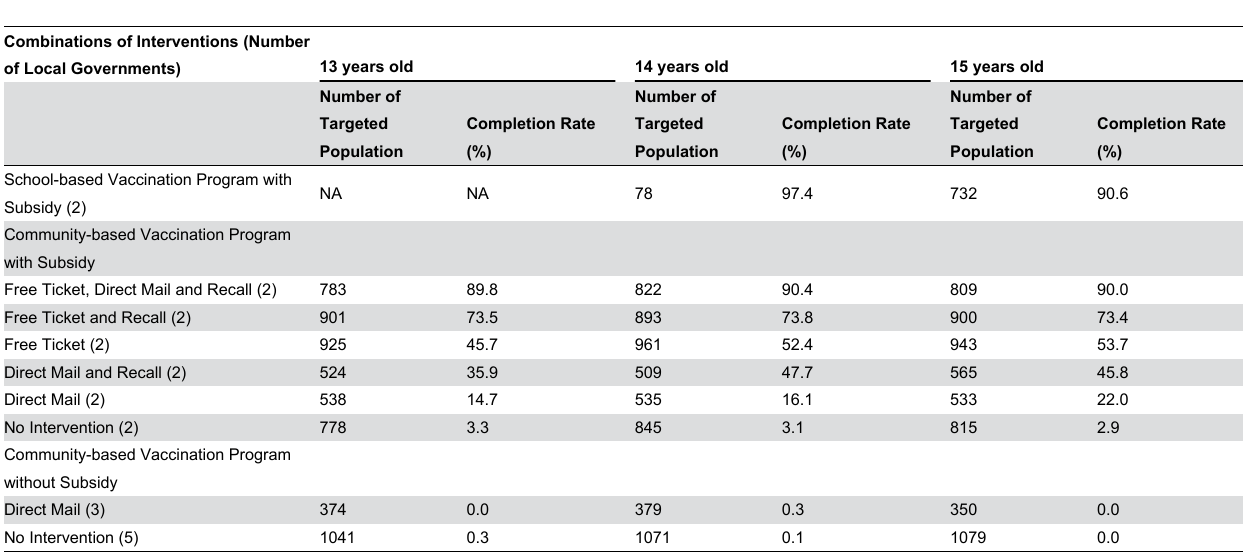
Table 1. Completion rates of HPV vaccination by targeted age according to combinations of interventions.